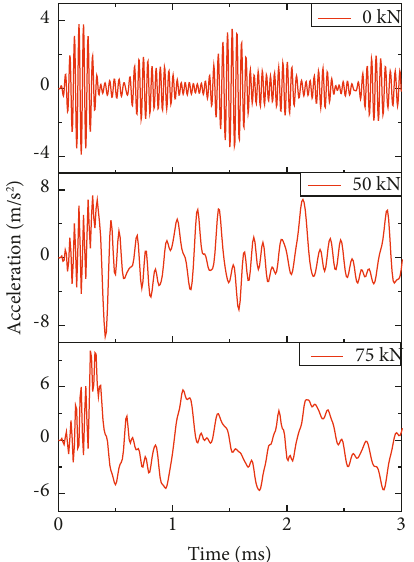
Figure 12: The wave propagation signal in the rock bolt with one bond defect (far away from the B-end 300mm) under pullout